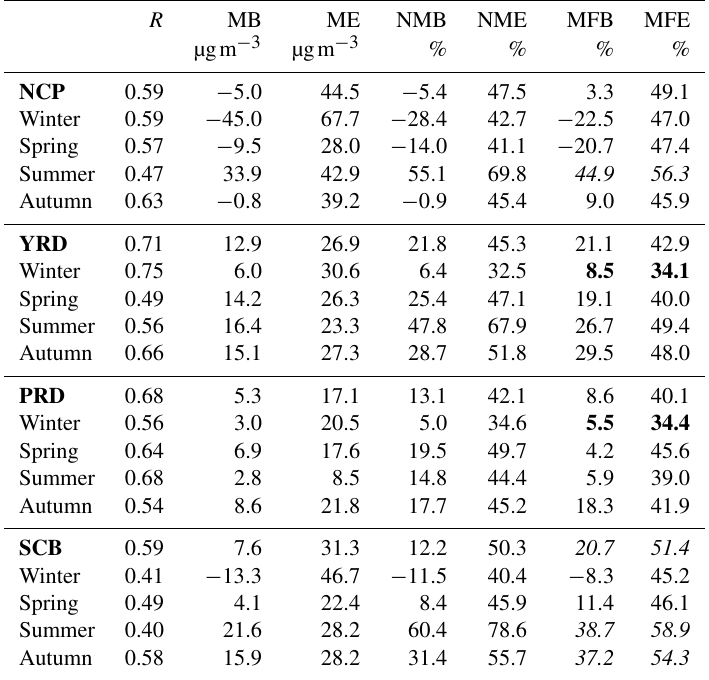
Table 3. Statistical metrics for hourly PM 2 . 5 in four haze-contaminated areas (2013–2017), in which bold, normal and italic font for MFB and MFE correspond to the “excellent”, “good” and “average” levels in Morris et al. (2005), respectively. R